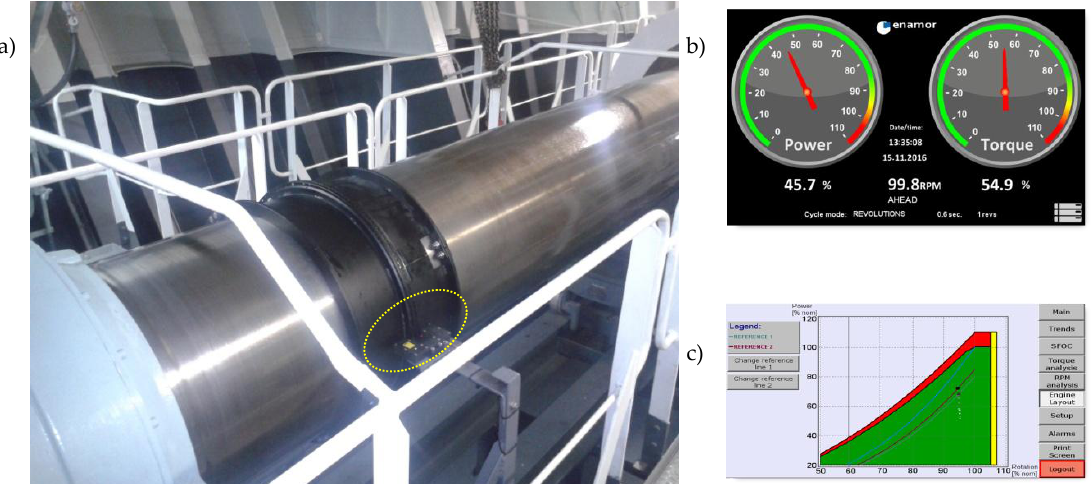
Figure 7. Propulsion control assistance system ETNP-10, where position of photo-optical detector is marked by ellipse, a ) two teeth rings installed on propeller shaft with photo-optical detector, b ) example of measurements, c ) actual engine load based on engine layout (Courtesy of Enamor Ltd.).